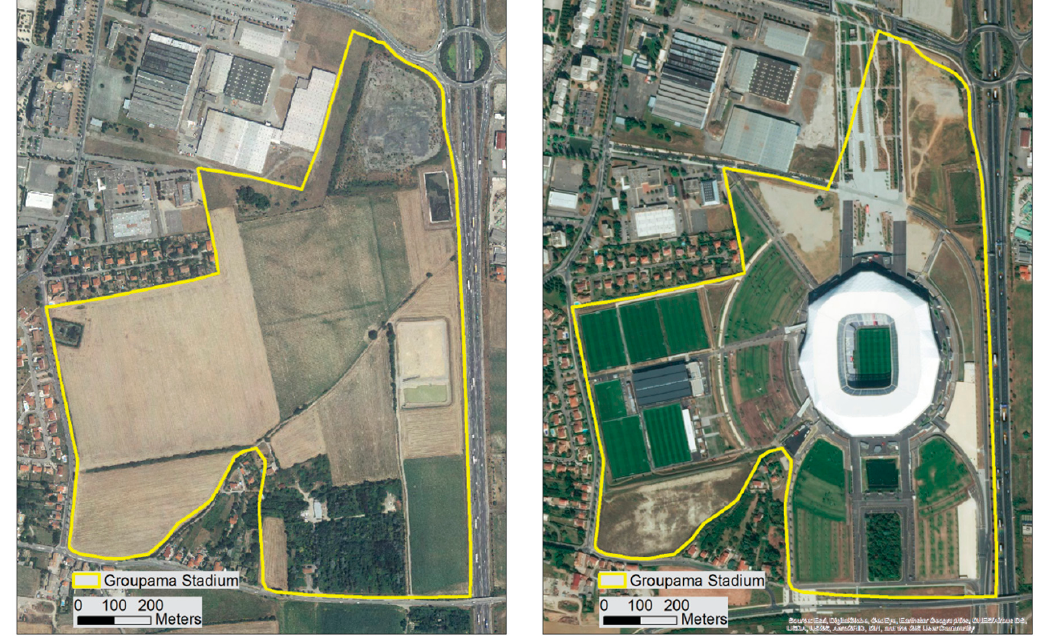
Figure 4. Groupama Stadium site in 2003 ( left ) and 2017 ( right ).